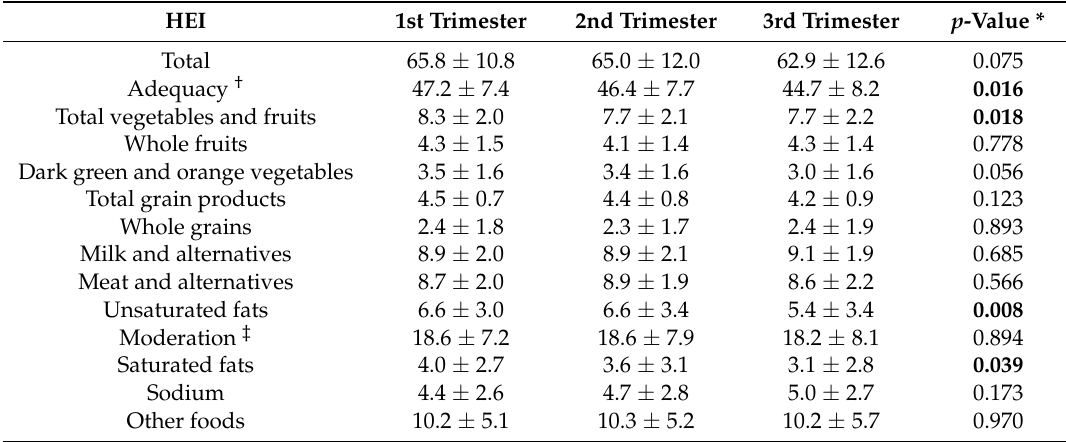
Table 3. Healthy Eating Index total and subscores throughout